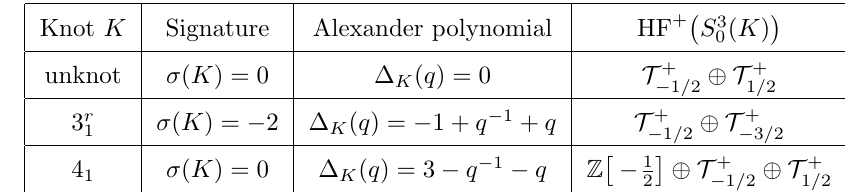
Table 3 . Simple 0-surgeries on knots. In all these examples HF + ( S 3